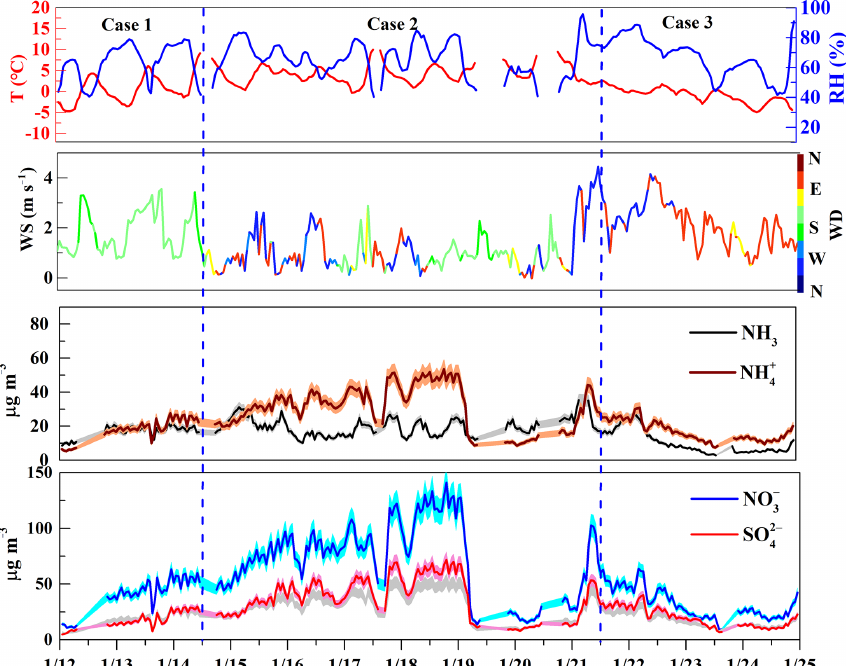
Figure 2. Temporal variations of T , RH, wind speed (WS), wind direction (WD), and concentrations of NH 3 , NH 4 + , SO 42 − , and NO 3 − during three cases at the Zhengzhou (U-ZZ) site. The shaded areas represent the measurement uncertainties.